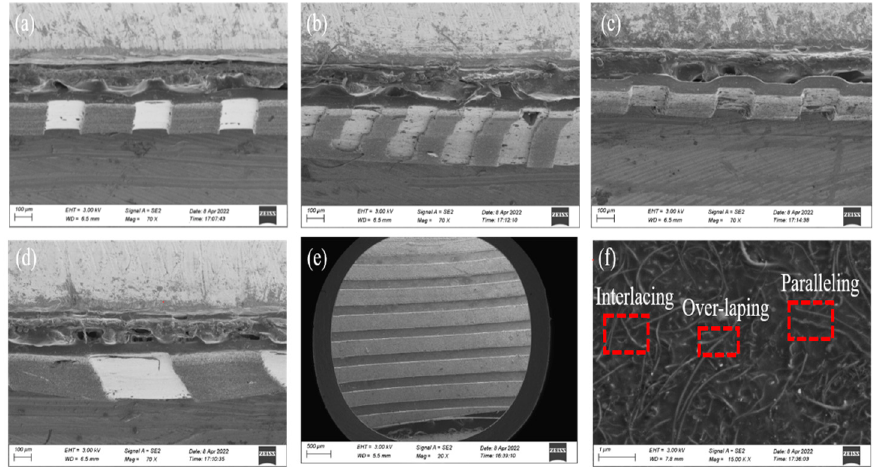
Figure 6. Scanning electron microscopy (SEM) images of MCNFs. Cross-sectional microstructures of ( a ) Model − A, ( b ) Model − D, ( c ) Model − E, and ( d ) Model − G. ( e ) SEM image of the bottom surface of a Model − G MCNF. ( f ) SEM image of the MWCNTs on the bottom surface of an MCNF.